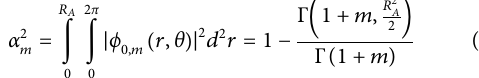
FIGURE 5 A cone can be obtained from fan-shaped geometry after gluing two edges